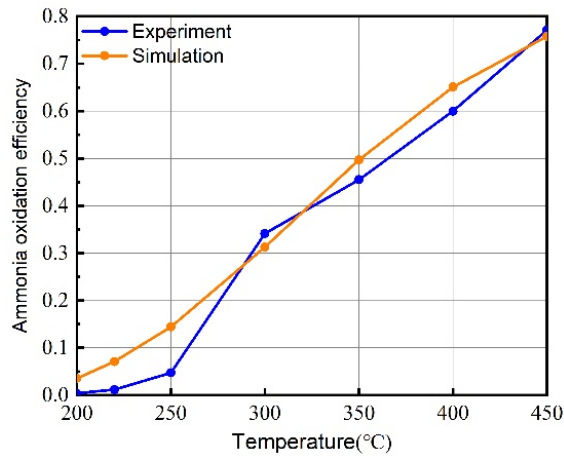
Figure 6. Comparison between experimental and simulation results of ammonia oxidation efficiency.